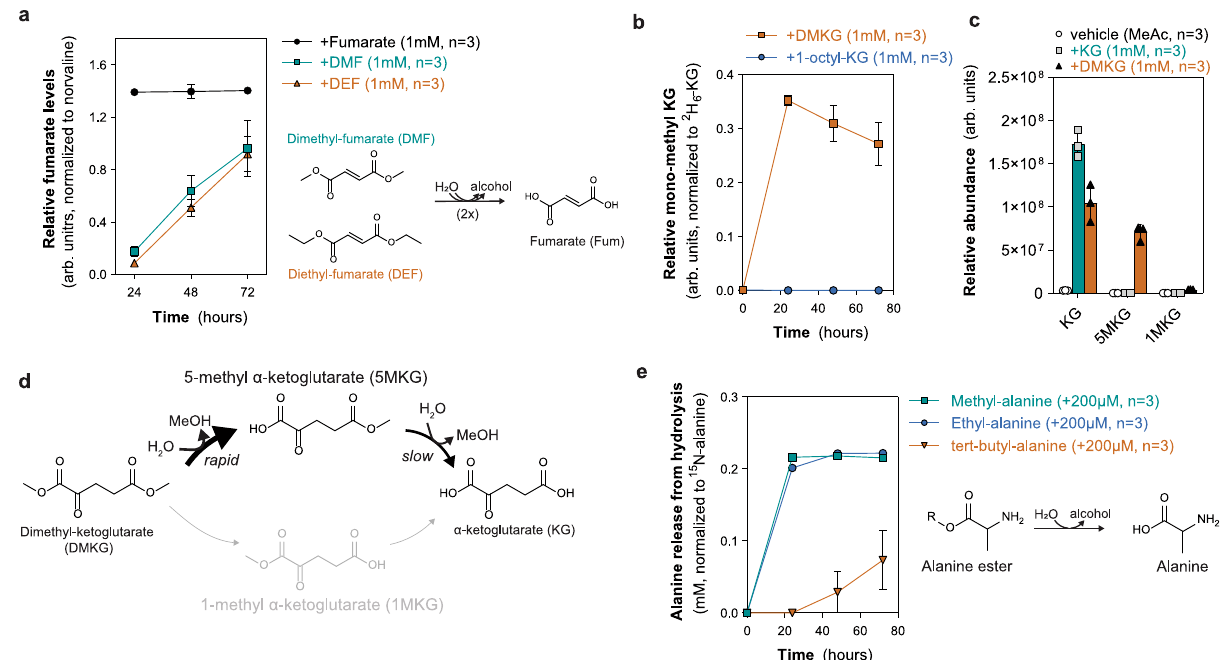
Fig. 2 Ester hydrolysis is common and dependent on hydrophobicity of ester group. a Time course of relative fumarate levels resulting from double hydrolysis of 1 mM of dimethyl-fumarate (DMF) or diethyl-fumarate (DEF) over 72 h compared to 1 mM of fumarate. Hydrolysis was performed in cell-free conditions. Data are mean ± s.d., n = 3 biologically independent experiments. b Time course of relative (1/5)-methyl KG levels quanti fi ed by GC-MS after cell-free hydrolysis of 1 mM of DMKG or 1-octyl-KG over 72 h. Data are mean ± s.d., n = 3 biologically independent experiments. c Relative levels of KG, 5- methyl-KG (5MKG), and 1-methyl-KG (1MKG) in 8988T cells treated with methyl acetate or 1 mM of KG or DMKG for 3 h quanti fi ed by LC-MS. Data are mean ± s.d., n = 3 biologically independent samples. d Schematic depicting rapid hydrolysis of the ester moiety proximal to the α -ketone of KG, producing 5-methyl- α -ketoglutaric acid (5MKG). Subsequent hydrolysis of the distal methyl-ester occurs at a slower rate and releases α -ketoglutaric acid (KG). e Absolute alanine concentration released after cell-free hydrolysis of 0.2 mM methyl-alanine, ethyl-alanine, or tert-butyl-alanine over 72 h. Tert-butylated alanine exhibits a slower hydrolysis rate. Data are mean ± s.d., n = 3 biologically independent